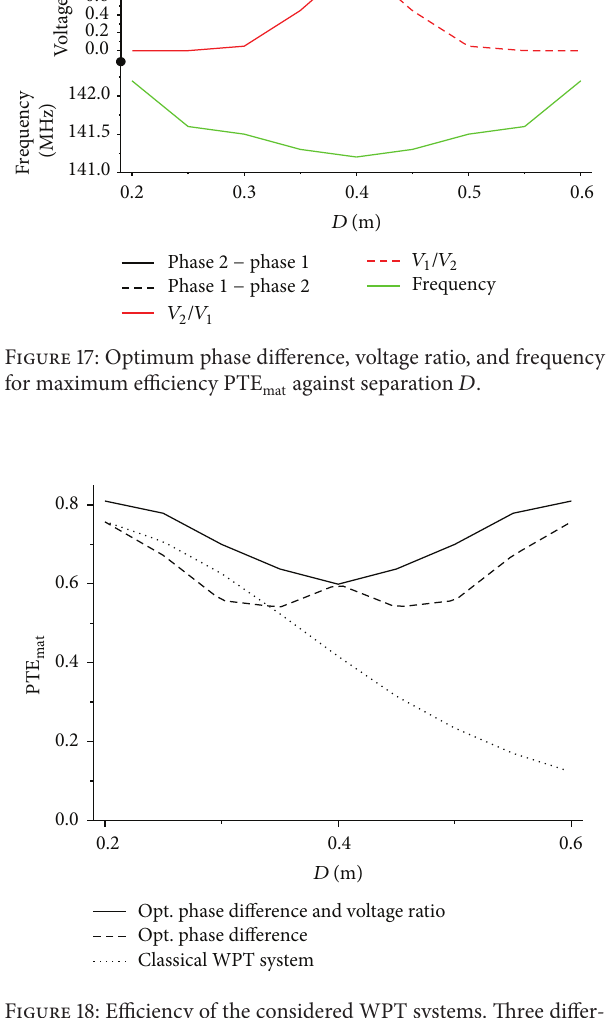
Figure 18: Efficiency of the considered WPT systems. Three differ- ent systems are considered: a WPT system with two transmitters, phase difference, and voltage ratio optimized for each separation 𝐷 (solid line); a WPT system with two transmitters and phase difference optimized for each separation 𝐷 (dashed line); the classical WPT system shown in Figure 5(b) (dotted